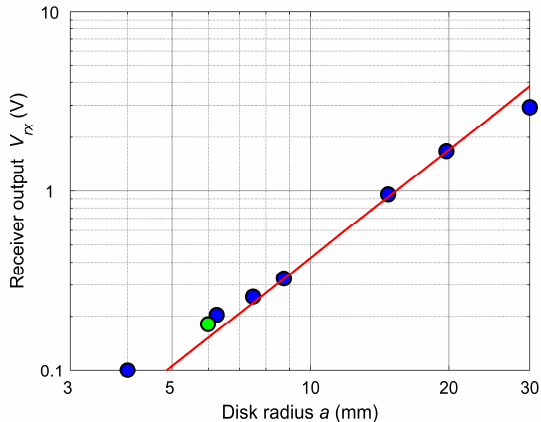
Figure 3. Calibration using disks of radius a (blue circles) and a portion of a blade of grass (green circle). The expected dependence is shown by the solid red line. The measured beam pattern for intensity is shown in Figure 4. The pattern very closely matched the Airy disk diffraction pattern over the central lobe. However, the side lobes, due to the finite number of sensors dominating from a radius of 0.2 m, projected onto the ground at a distance of 0.78 m (a beam angle of 14 ° ). These side lobes were –20 dB, down from the –3 dB width at 68 mm radius, and are acceptable. Also shown, in green, are the measurement standard deviation around the measured pattern. The measurement error is very small. The asymmetry in the side lobe intensities is to be expected because the locations of the sensors were not symmetric.